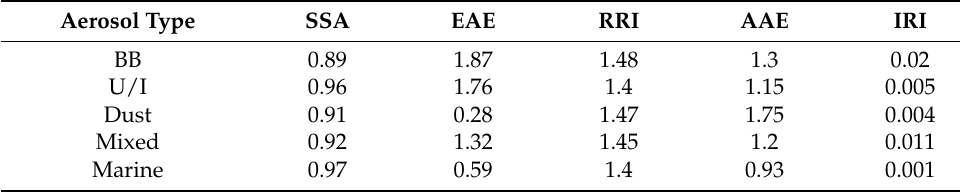
Table 2. The centroids of 5 reference parameters of each aerosol type. Aerosol Type SSA EAE RRI AAE IRI BB